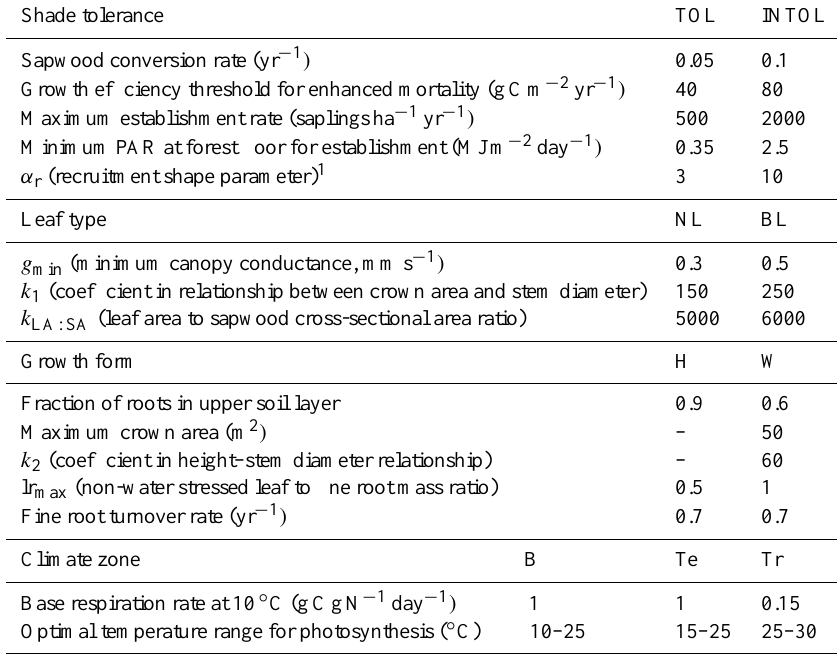
Table B2. PFT characteristics common to the shade tolerance, leaf type, growth form and climate zone categories in Table